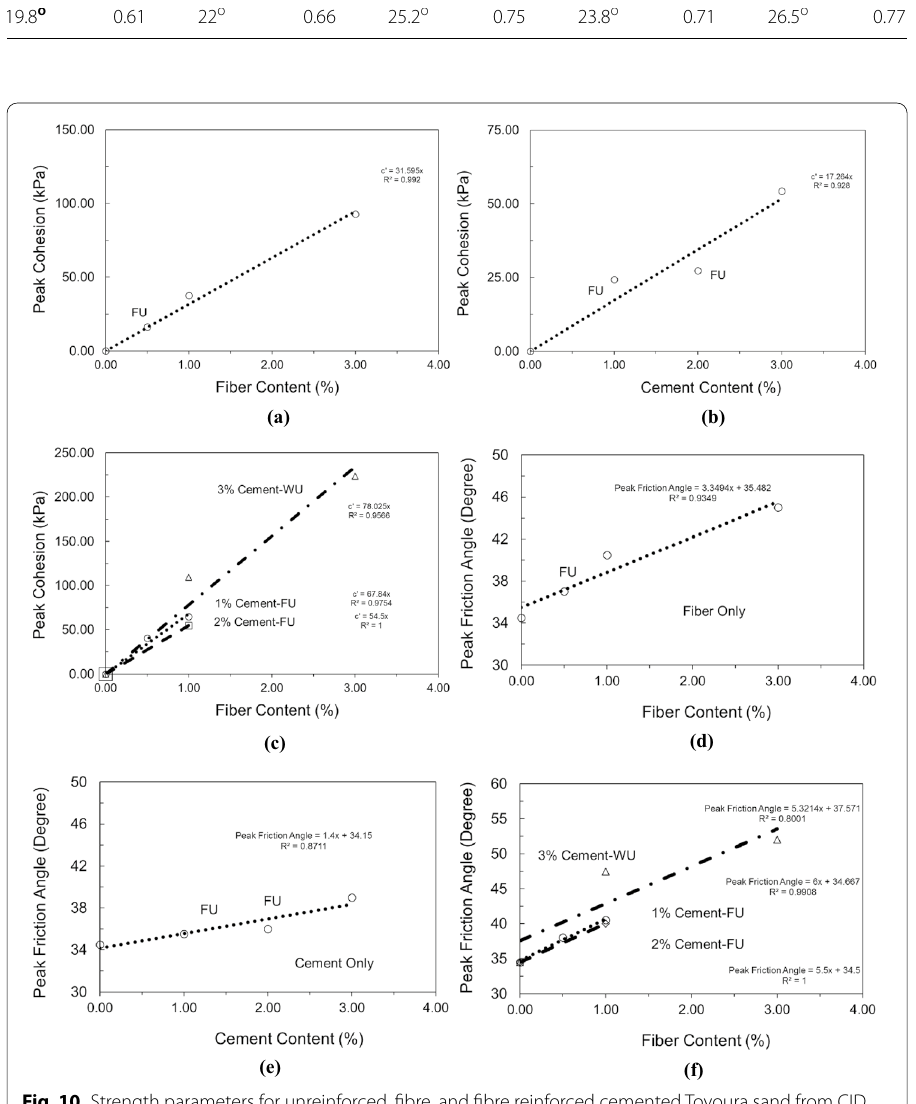
fibre reinforced Hostun sand [3, 37, 39]. Table 5 summarizes the results of critical state ′ friction angle ( ϕ cs ) and slope of the critical state line ( M ) obtained from CID extension tests.